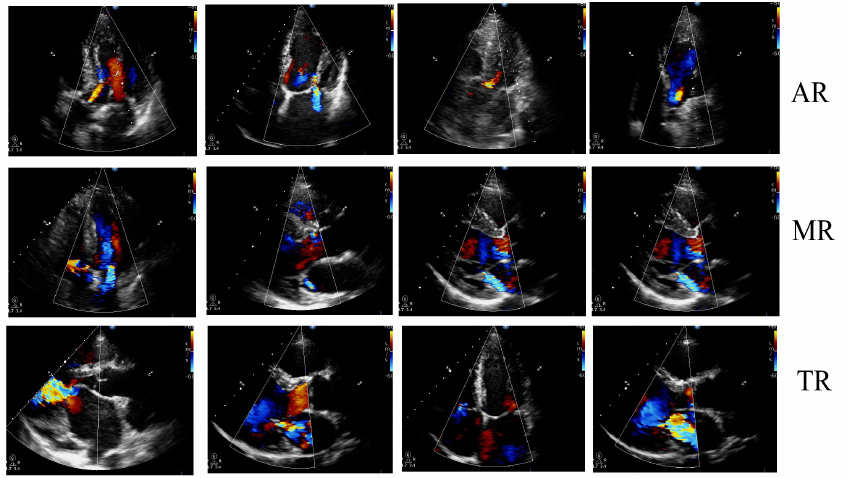
Figure 4. Input images for AR, MR, and